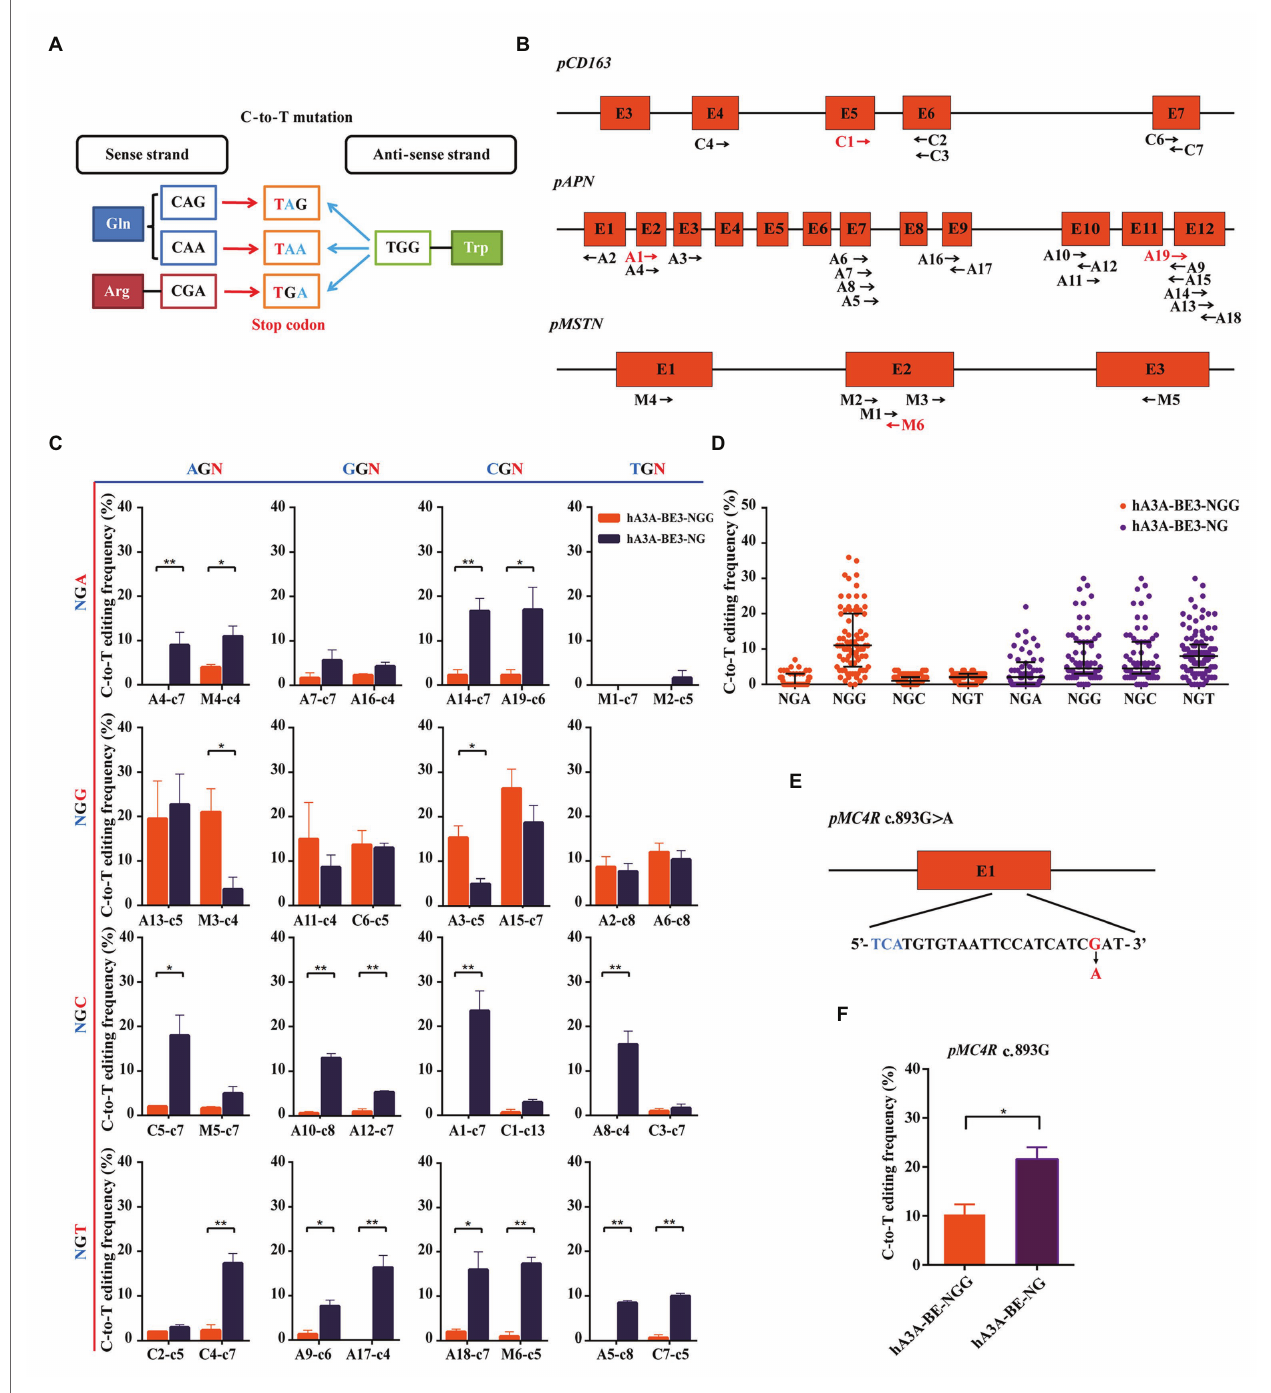
FIGURE 3 | Precision missense mutation using hA3A-BE3-NG to expand the editing scope in porcine fetal fibroblast (PFF) cells. (A) Representation of the C-to-T conversion induced by base editors to generate stop codons. The base editors convert CAA, CAG, and CGA codons to stop codons (red) in the sense strand. The TGG codon is converted to stop codons (blue) through G-to-A conversion. (B) Schematic of the target sites at the porcine CD163 , APN , and MSTN loci. The target sites indicated by the black arrows can generate stop codons using base editors (BEs). The forward direction of arrow indicates sgRNA-matched anti-sense strand, and vice versa. Total of 32 sgRNAs were designed (A1–19, C1–7, and M1–6). (C) Base editing at 32 NGN PAM sites by hA3A-BE3 and hA3A-BE3-NG. The target sites covered all 16 possible NGN PAM combinations, counting the end distal to the PAM as position 1. (D) Statistical analysis of the C-to-T editing frequency induced by hA3A-BE3 or hA3A-BE3-NG at a total of 32 endogenous target sites. The median and IQR are shown. (E) Schematic of the target site at MC4R locus. MC4R c.893G>A could be produced by hA3A-BE3-NG. The PAM sequence and substituted base are shown in blue and red, respectively. (F) Base editing at the MC4R locus by hA3A-BE3 and hA3A-BE3-NG. In (C,F) values were shown as mean ± SEM ( n = 3); ** p < 0.01 and * p <